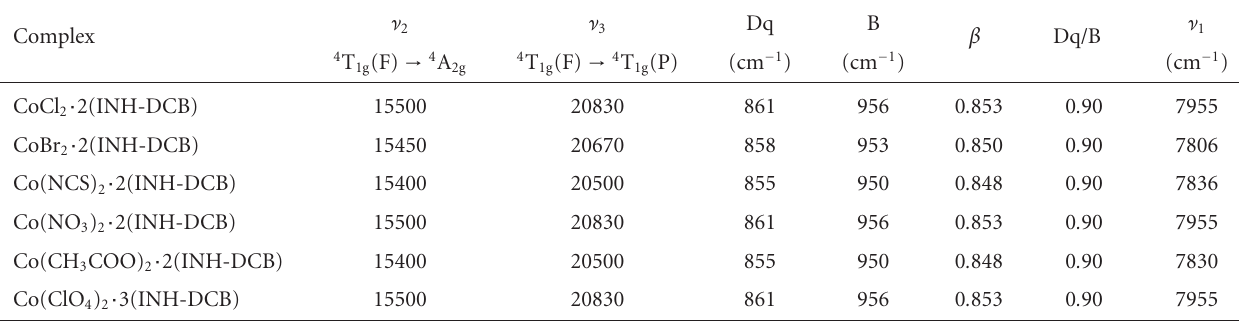
Table 4: Electronic spectral bands (cm − 1 ) and ligand-field parameters of Ni 2+ complexes of INH-DCB. Complex ν